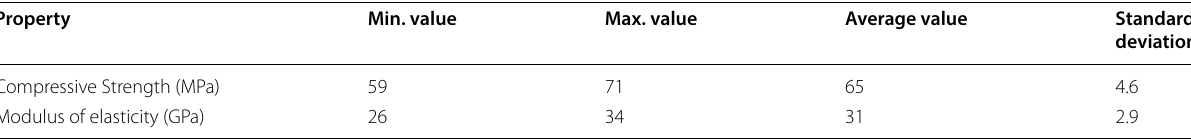
Table 2 Mechanical properties of normal high grade concrete.